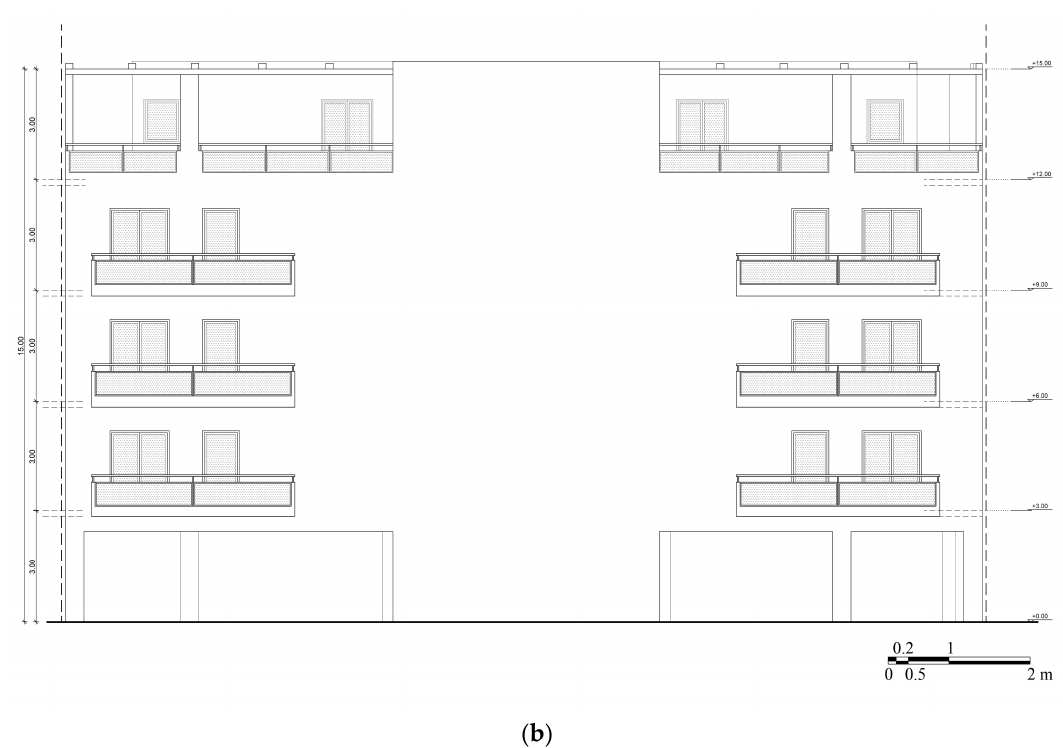
Figure A3. Reference building drawings of ( a ) front (South) elevation and ( b ) back (North) elevation.